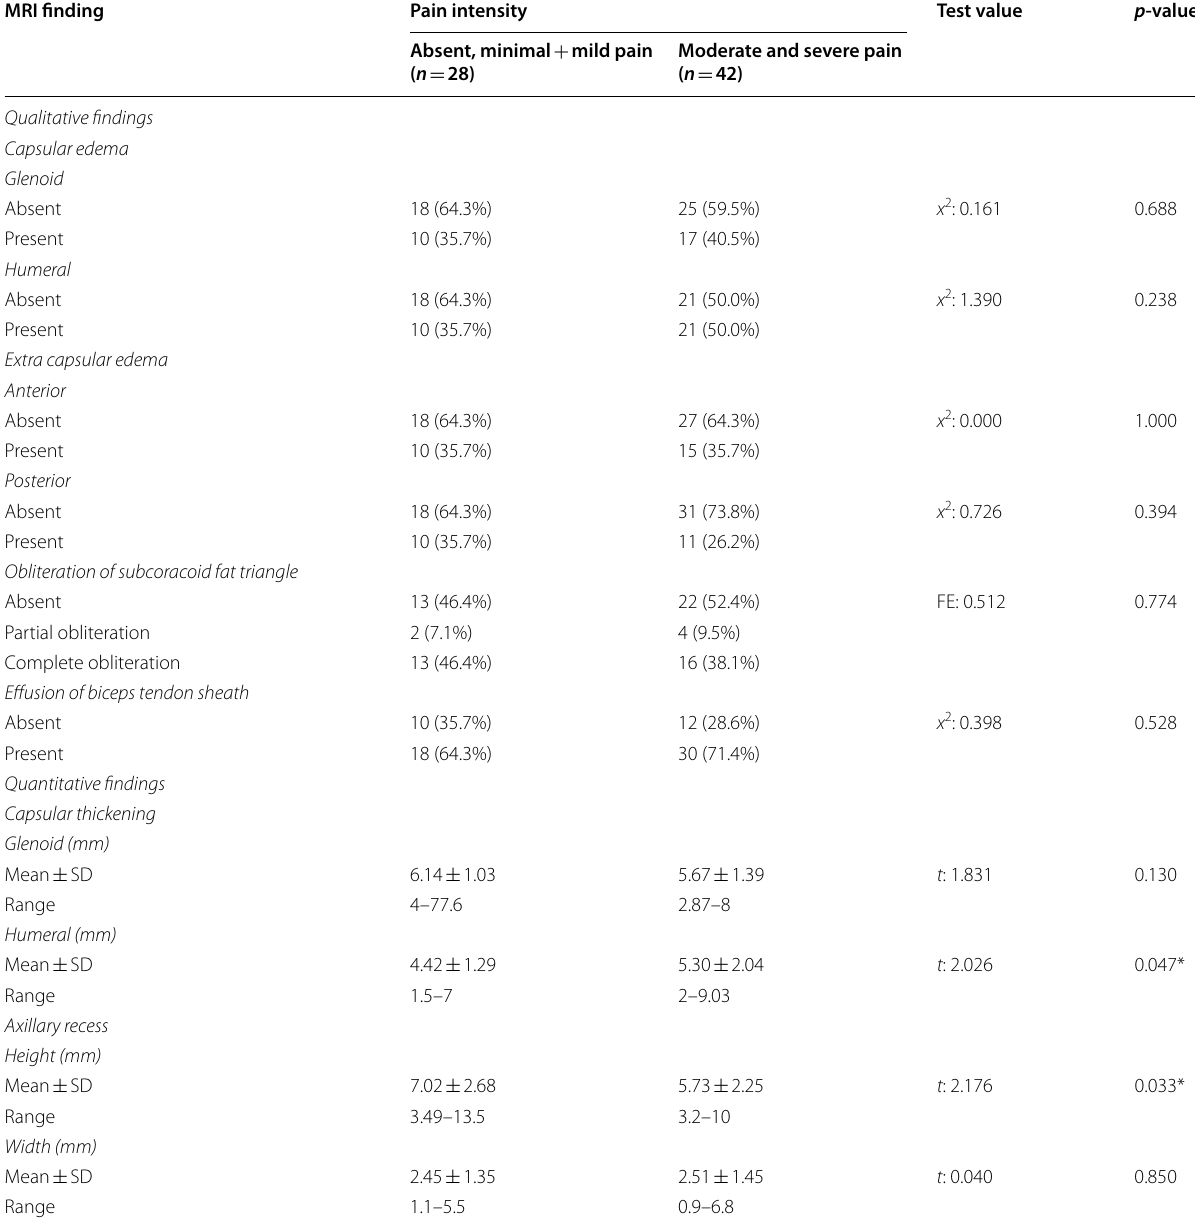
Table 5 Association between levels of pain intensity according to MRI finding (n